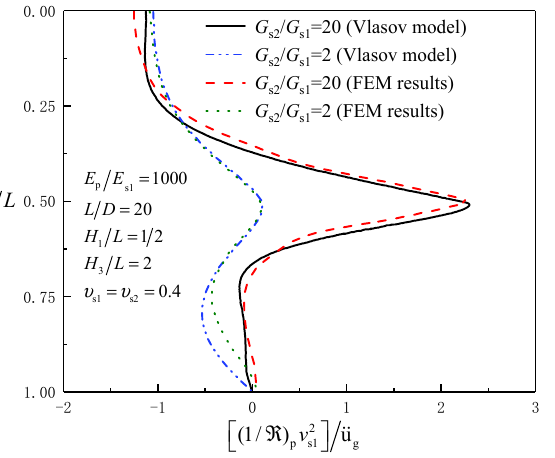
Figure 16. Results derived from the Vlasov model compared to the continuous model (reproduced from Ke et al. (2019) [170]).